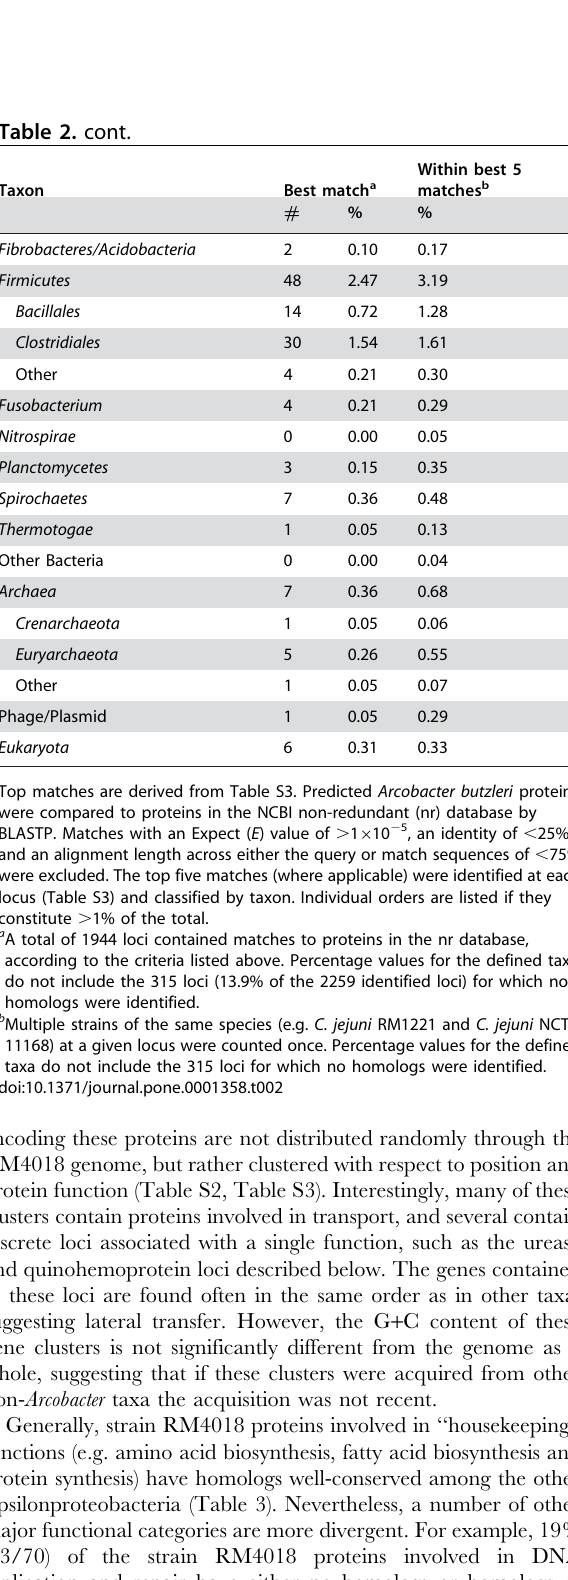
(Table 3). Other divergent functional categories include: sulfur/ nitrogen metabolism (34%), transcriptional regulators/ s -factors (47%), signal transduction (49%), cell envelope (37%), chemotaxis (70%) and antibiotic resistance (36%) (Table 3). These divergent functional categories will be discussed in further detail.